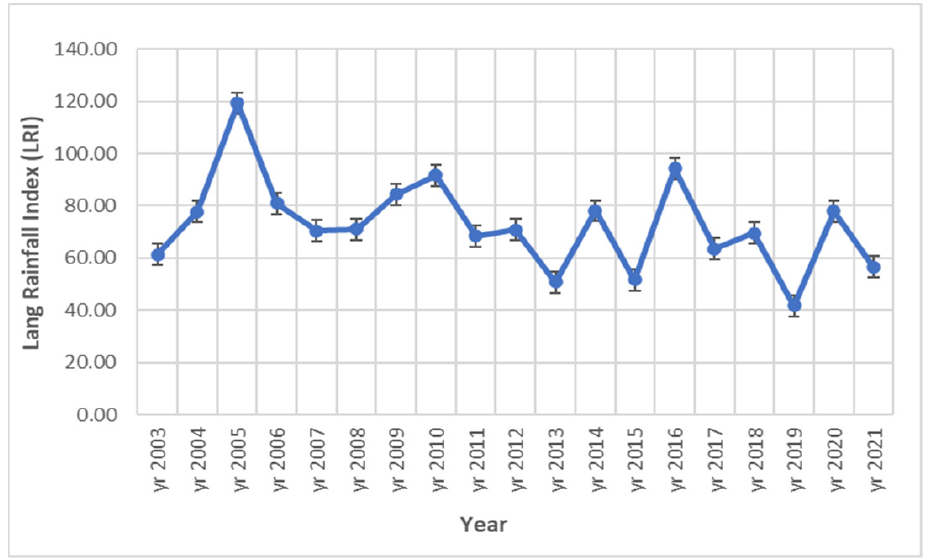
Figure 2. Dynamics of Lang Rainfall Index (R) during 2003–2021 time interval in ex-arable grassland from Gr ă dinari (standard error displayed).